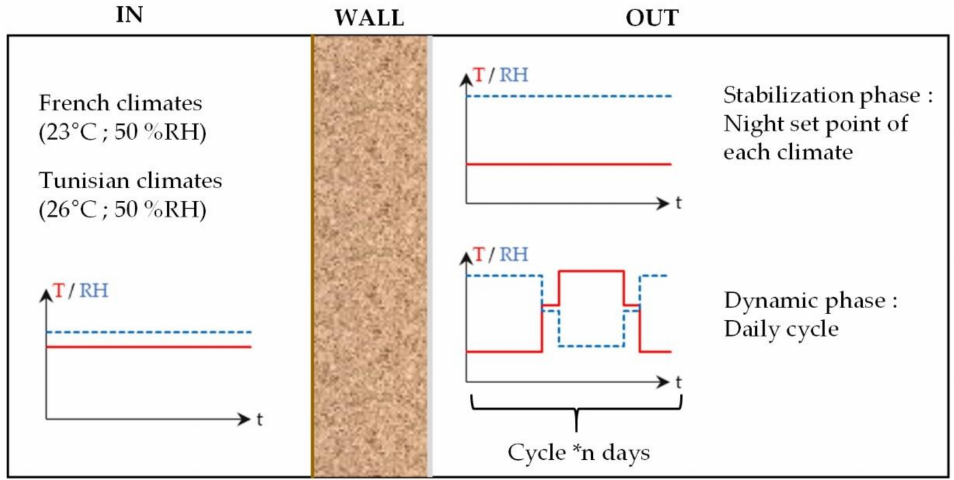
Figure 5. Indoor and outdoor set points during the